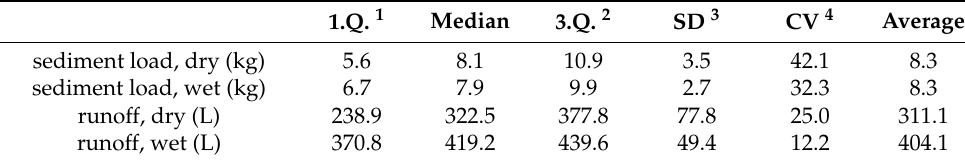
Table 3. Box plot